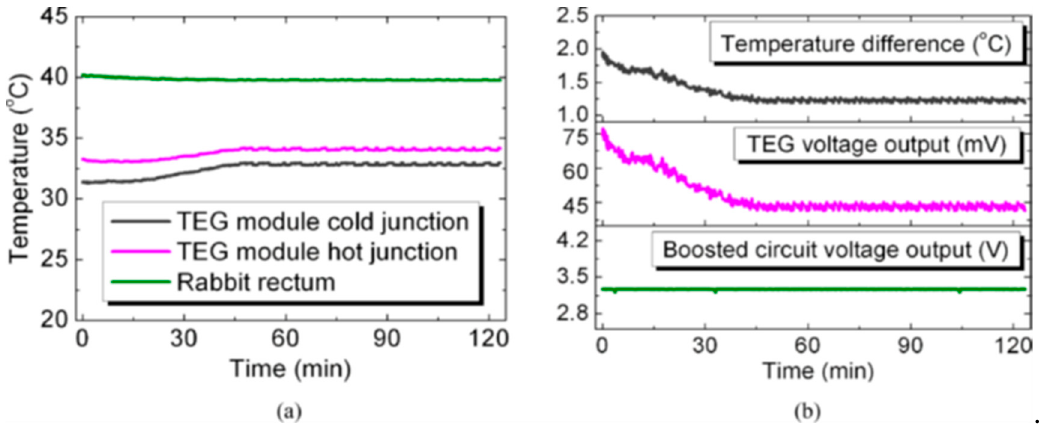
Figure 17. ( a ) Temperature profile of TEG and rabbit rectum; ( b ) output voltage in relation to temperature difference [94].